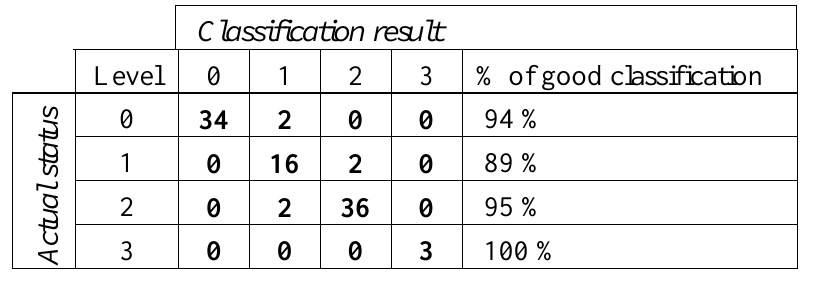
Figure 7. Representation of oil-palm trees in the plane defined by the two first eigenvectors of PLS-DA: healthy palms are displayed in diamond, Level 1 in square, Level 2 in triangle, and Level 3 in circle